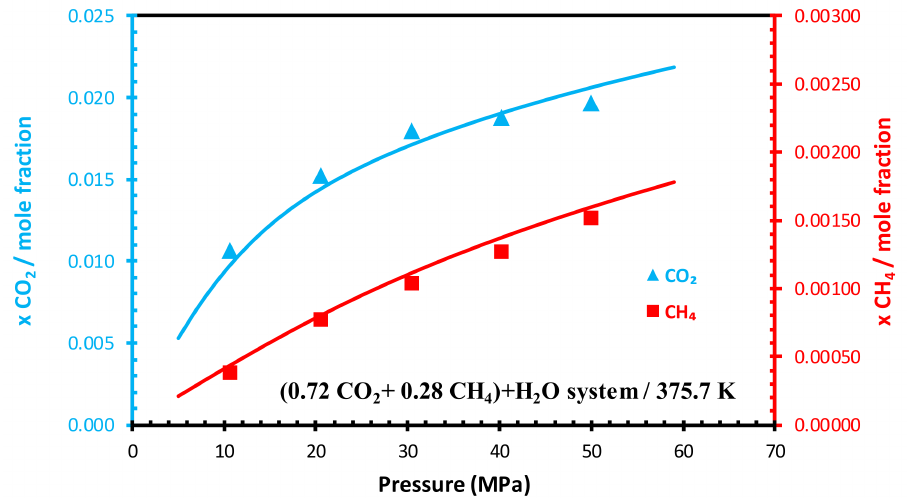
Figure 10. Mixed-gas cosolubility in CO 2 + CH 4 + H 2 O system: Comparison of SW EoS predictions (solid lines) with experimental literature data (symbols)